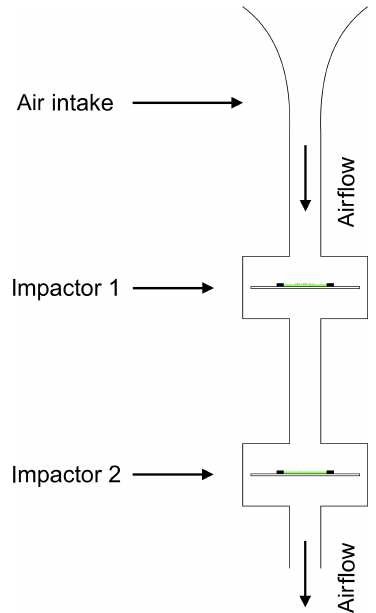
Figure 7. Schematic sketch of the extraction efficiency experiment with two identical impactors (impactor 1 and impactor 2) connected in a cascade configuration to investigate particle extraction effi- ciency. At 100% efficiency, all particles would be extracted by im- pactor 1, leaving no particles for impactor